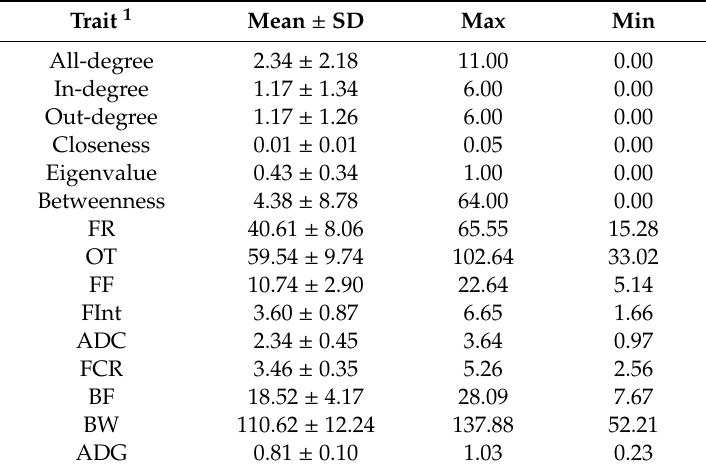
Table 3. Descriptive statistics for social network individual measures, feeding behaviour and performance traits of analysed Duroc